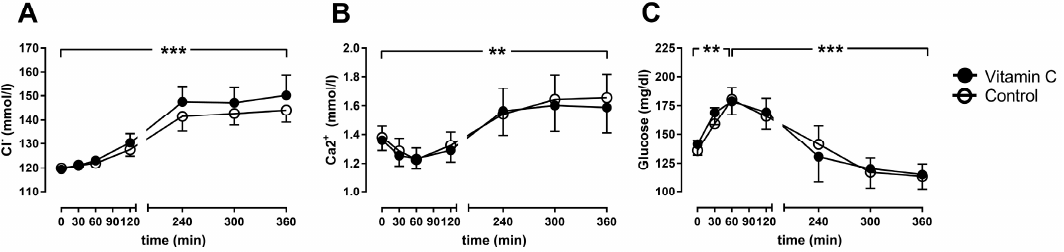
Figure 4. The arterial chloride- ( A ), calcium- ( B ) and glucose-concentrations ( C ). ** p < 0.01; *** p < 0.001 e ff ect of time for both groups.